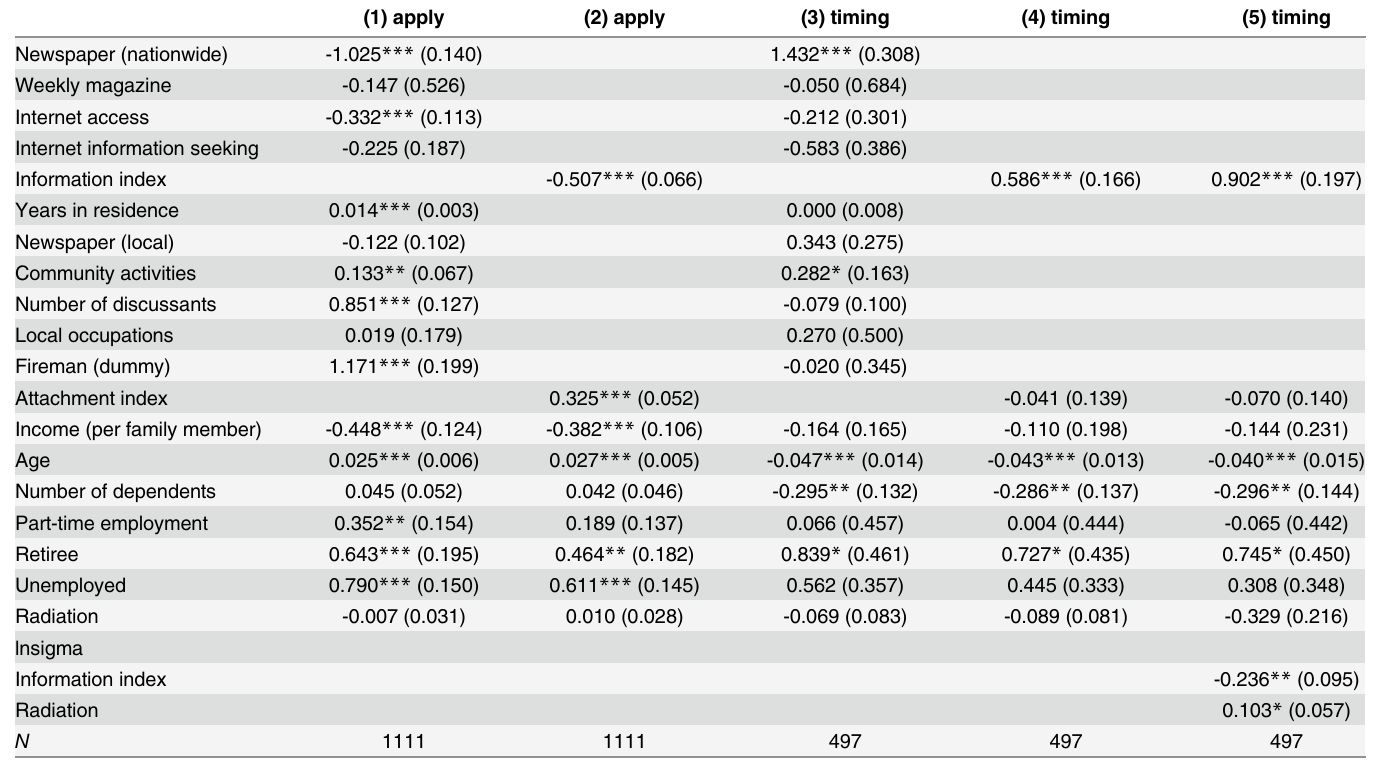
Table 2. Applying for temporary housing and the timing of